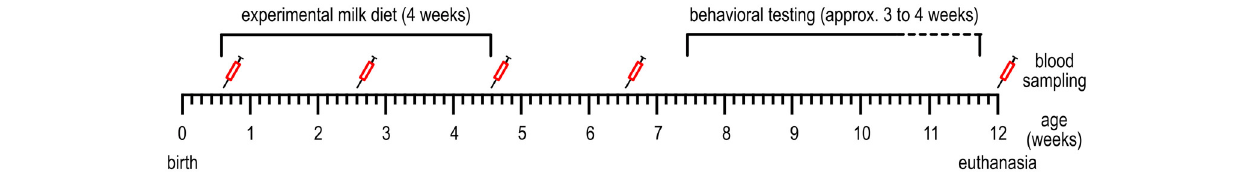
FIGURE 1 | Timeline of the events conducted during the experiment. See Table 1 for more detailed information.